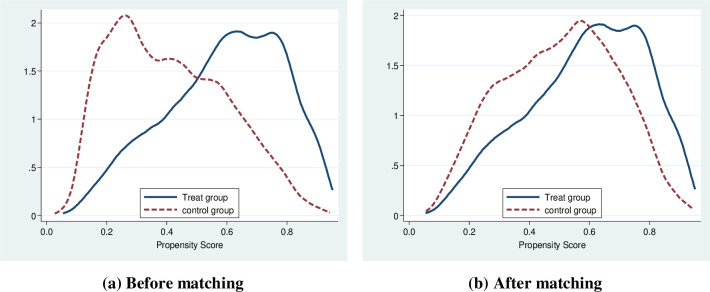
Distribution of propensity scores before and after matching.